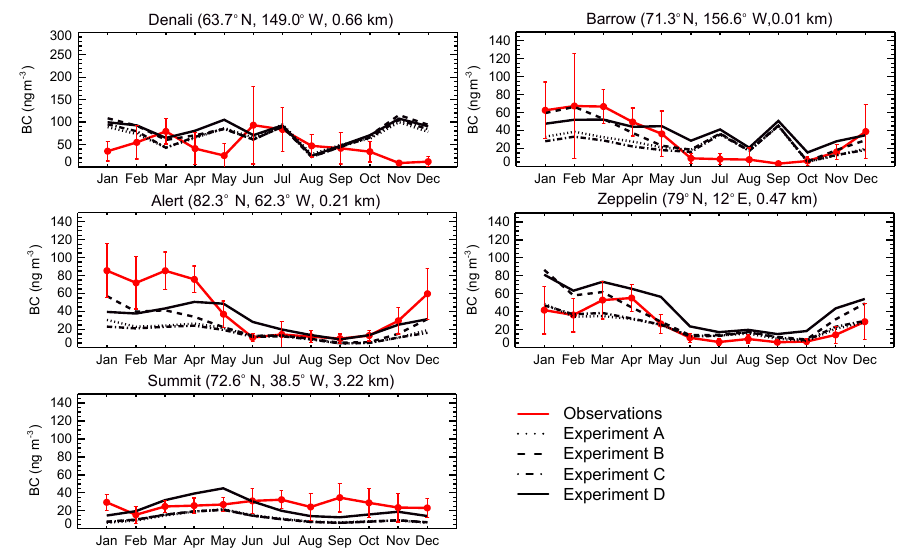
Figure 5. Observed (red solid) and GEOS-Chem simulated (black curves: dotted – Exp. A, dashed – Exp. B, dash dotted – Exp. C, solid – Exp. D; see Table 2 and text for details) BC concentrations in air (ngm − 3 ) at Denali, Barrow, Alert, Zeppelin, and Summit, averaged for 2007–2009. Also shown are standard deviations of observations (error